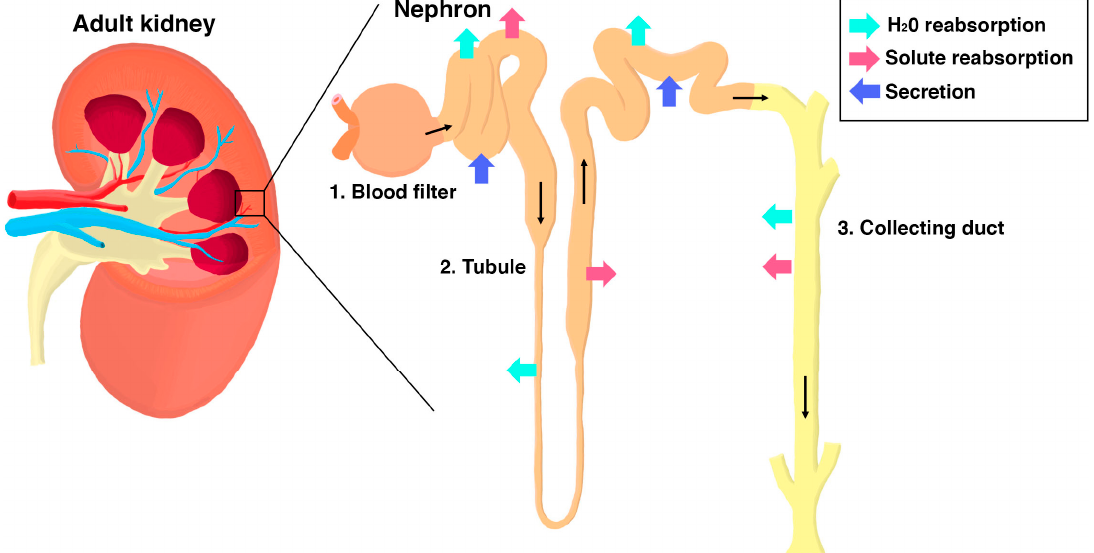
Figure 1. The nephron is the functional subunit of the kidney. ( left ) Schematic of a representative adult (metanephric) human kidney which contains millions of nephrons. ( right ) Each nephron has three major components: (1) the blood filter, (2) the tubule, (3) the collecting duct. Blood flows into the filter where a filtrate is formed. The filtrate then enters into the tubule where water and/or solutes are selectively reabsorbed or secreted. Regional differences in tubule epithelial cell characteristics establish a defined sequence of modifications. From the tubule, the waste product passes through the collecting duct where final adjustments are made in water and electrolytes before the urine is passed out of the kidney. Some example physiological functions (arrows) are indicated.